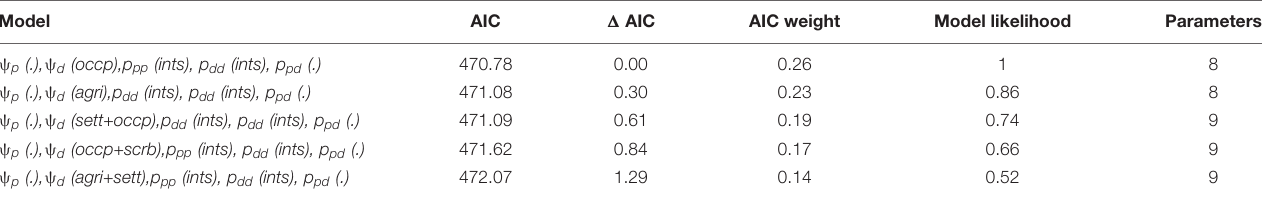
The top five models (based on AIC ranks) are presented. scrb, scrubland cover; sett, area of human settlements; agri, area of agriculture land; occp, occupancy probability of wolf; ints, number of interviews per site; models do not include combinations of highly correlated covariates (r > |0.7|).